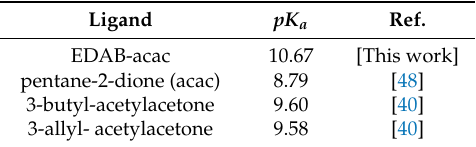
Table 1. The pK a values of EDAB-acac with other acac derivatives.